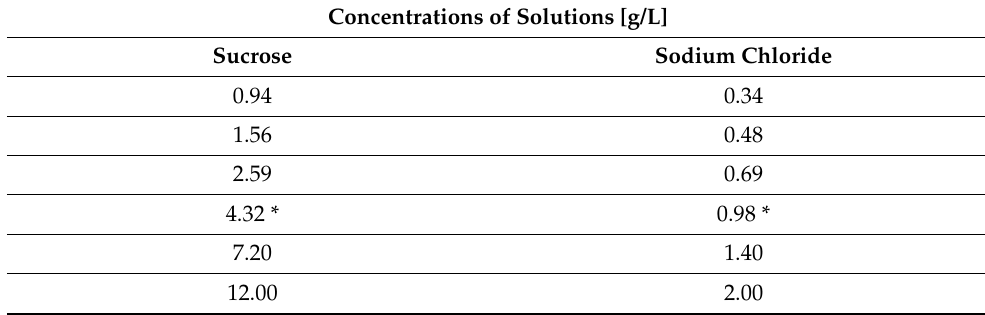
Table 1. Concentrations of flavour solutions used in the sensory test